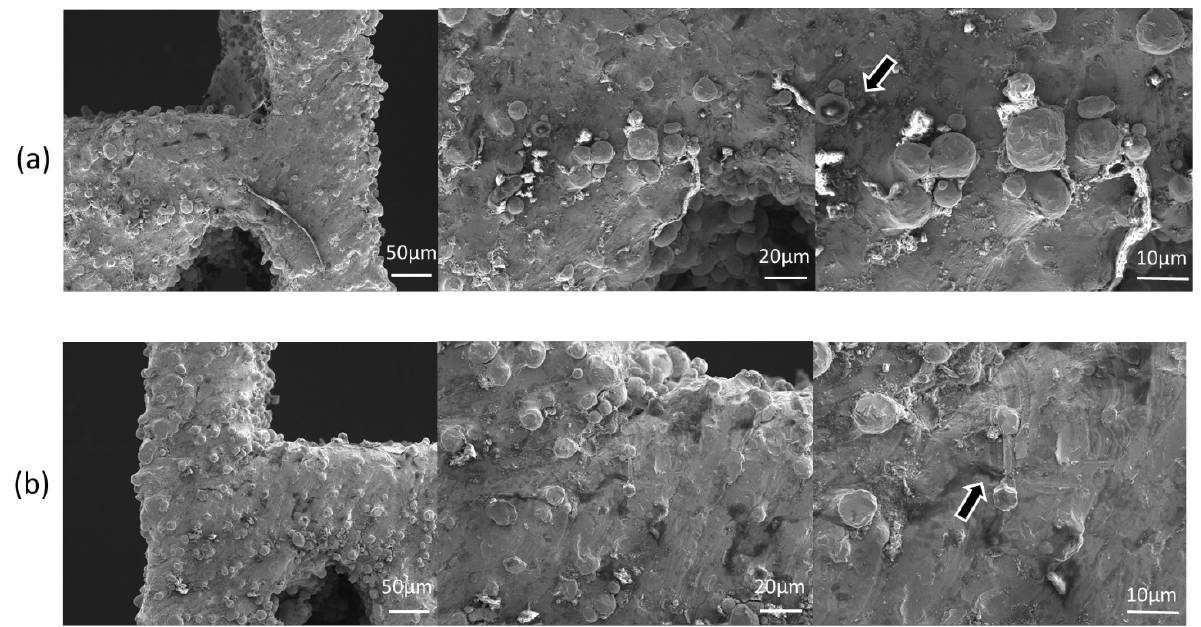
Figure 11. SEM of LPBF-manufactured scaffold loaded with randomly seeded HUVECs. The HUVECs (black arrow) appear to have a spread morphology with cord-like muti-cellular formations. ( a ) Co-cultured for 3 days; ( b ) co-cultured for 5 days.